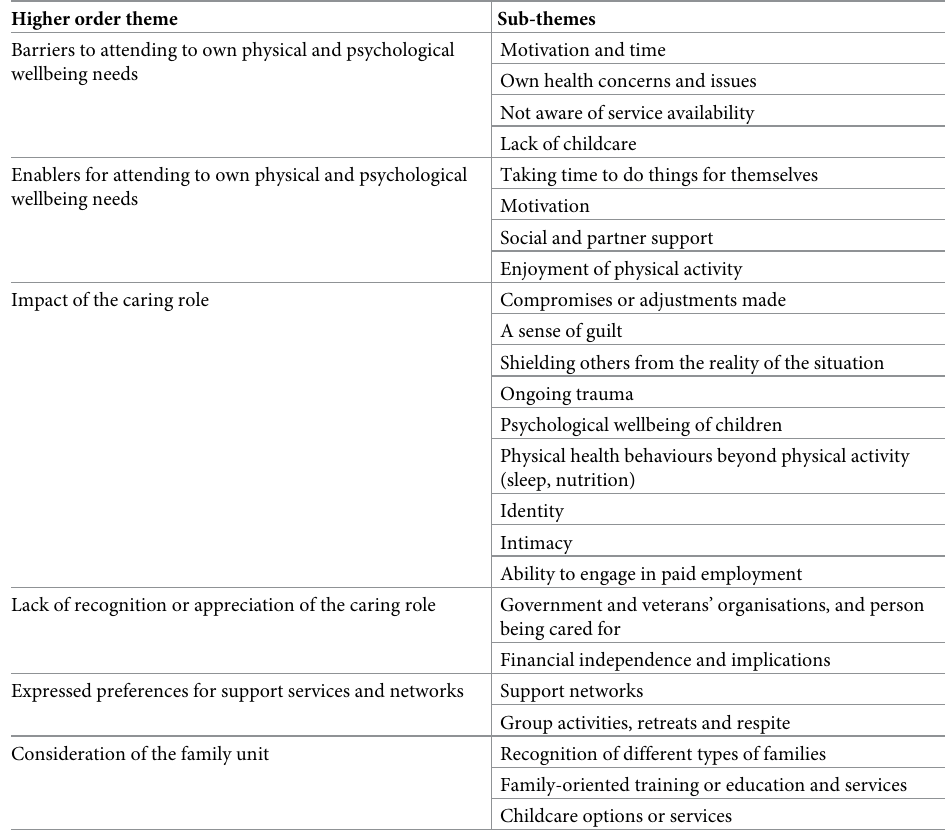
Table 2. Higher order themes and sub